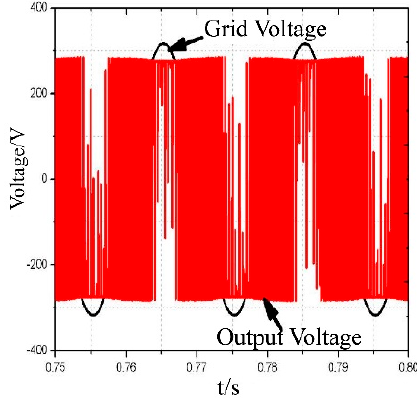
Figure 22. Voltage relation before grid connection.